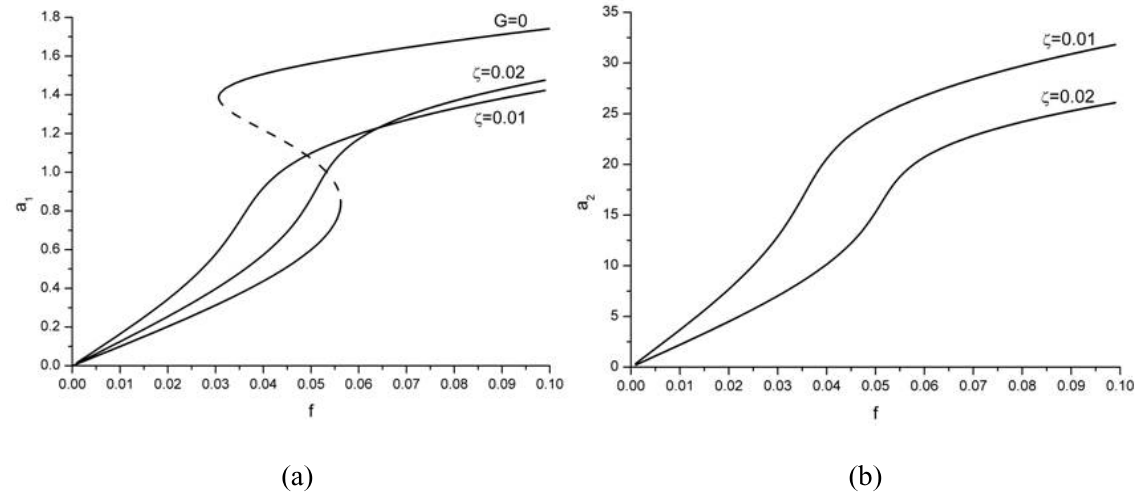
Fig. 11. Effect of varying the absorber’s damping on the force-response curves of (a) the plant and (b) the absorber when σ 1 = − 0 . 1 , G = 0 . 005 and ν 2 = − 0 . 02